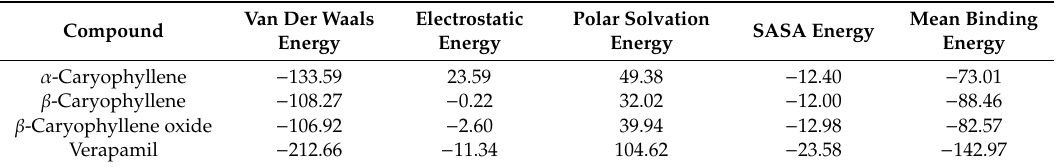
Table 3. Mean binding energy and its decomposed constituent’s energies (kJ/moL) for verapamil and the caryophyllane sesquiterpenes in the predicted binding site of P-gp calculated by MM-PBSA method.